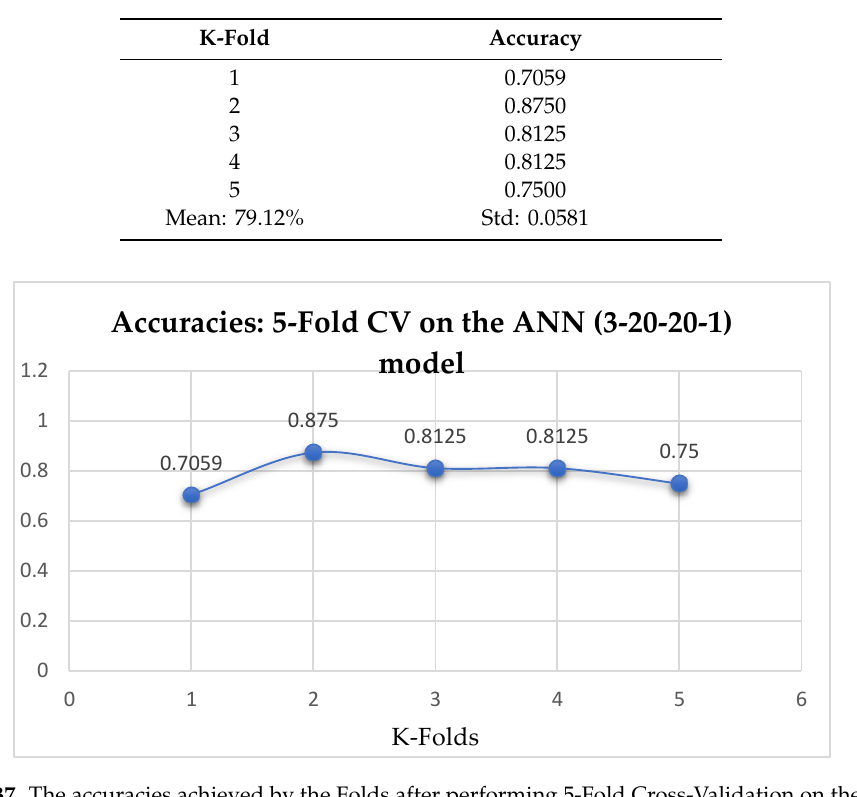
Figure 37. The accuracies achieved by the Folds after performing 5-Fold Cross-Validation on the ANN (3-20-20-1) model.